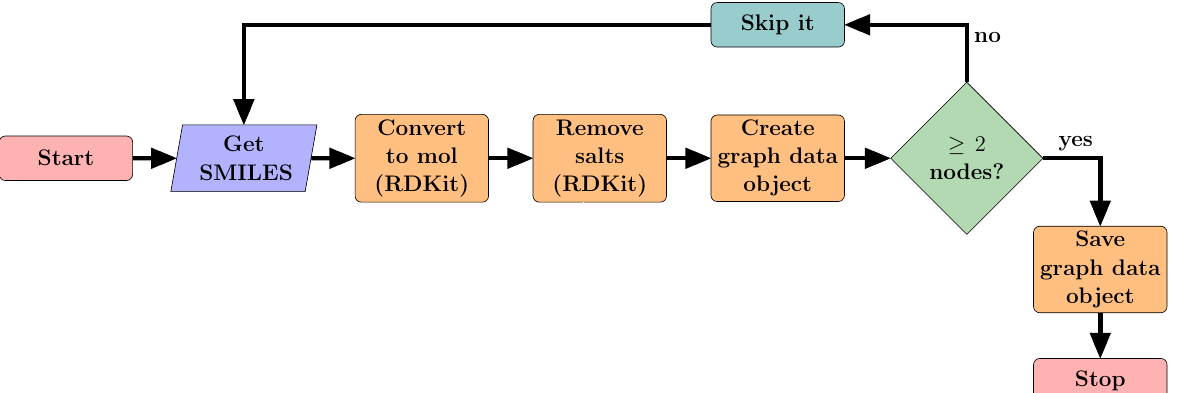
Figure 1. A flow chart showing how drug molecules were converted into and saved as graph data objects using RDKit [10] and PyG [18]. SMILES string representing drugs are converted into molecules using RDKit. Then salts are removed. The features from the atoms and bonds of the molecule are used to create a graph using PyG. This is then saved as a sample in the